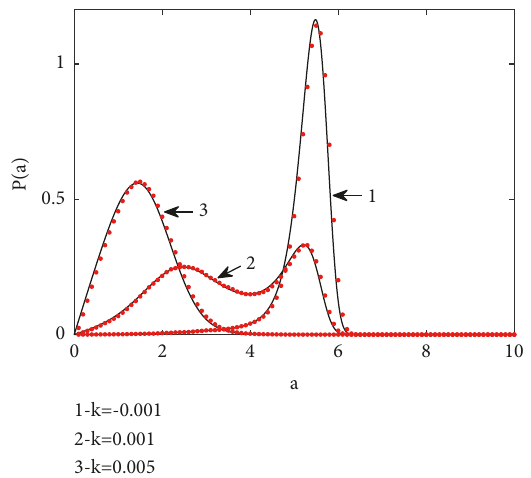
Figure 2: Stationary PDFs of the amplitude P (a) for various values of feedback strength 𝑘 . The solid lines stand for the analytic results and the dots denote the numerical simulations of original system.